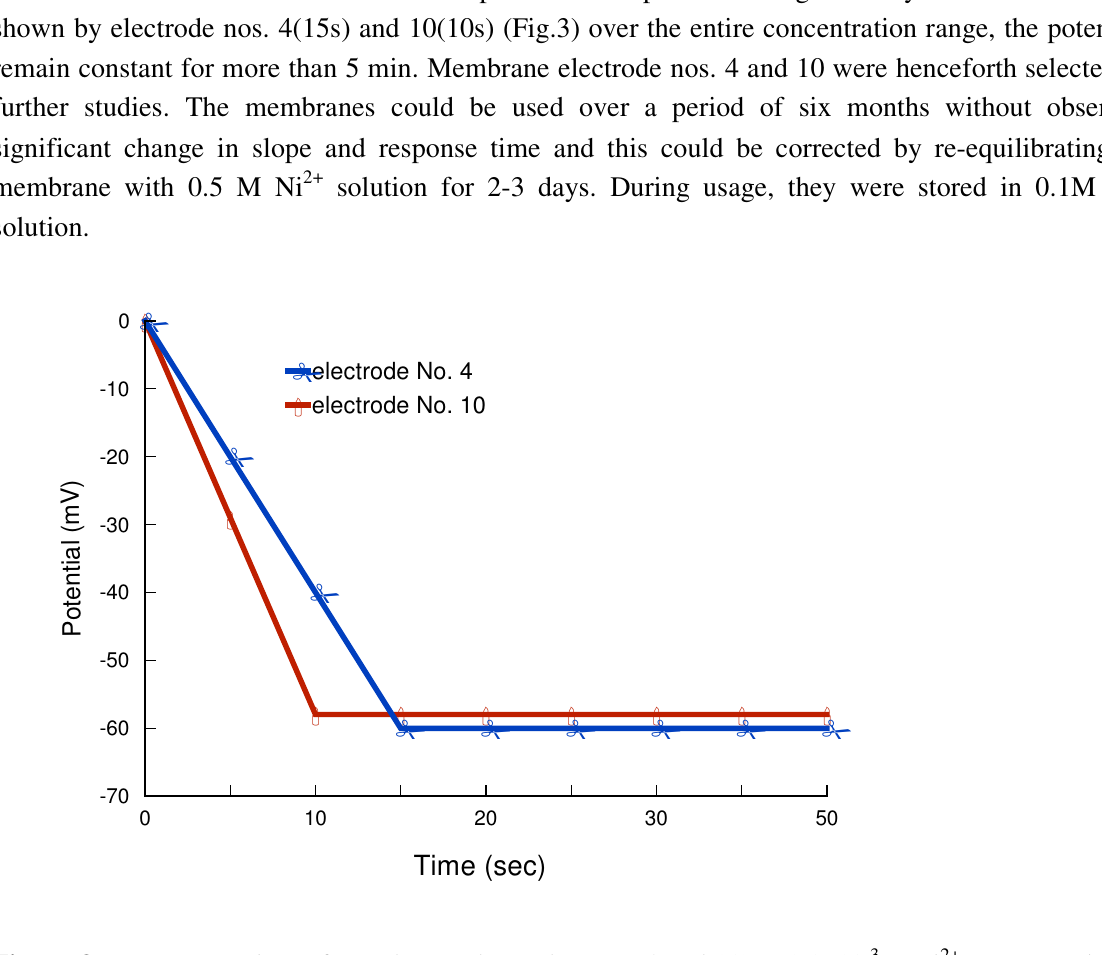
Figure 3: Response time of membrane electrode (Nos. 4 and 10) at 1.0x10 -3 M Ni 2+